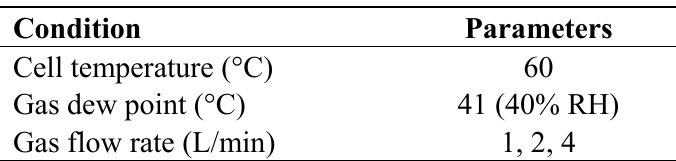
Table 2. After the gas purging, all of the gas valves are closed and the HFR variations are monitored for 20 min. Table 2. Gas purging conditions.